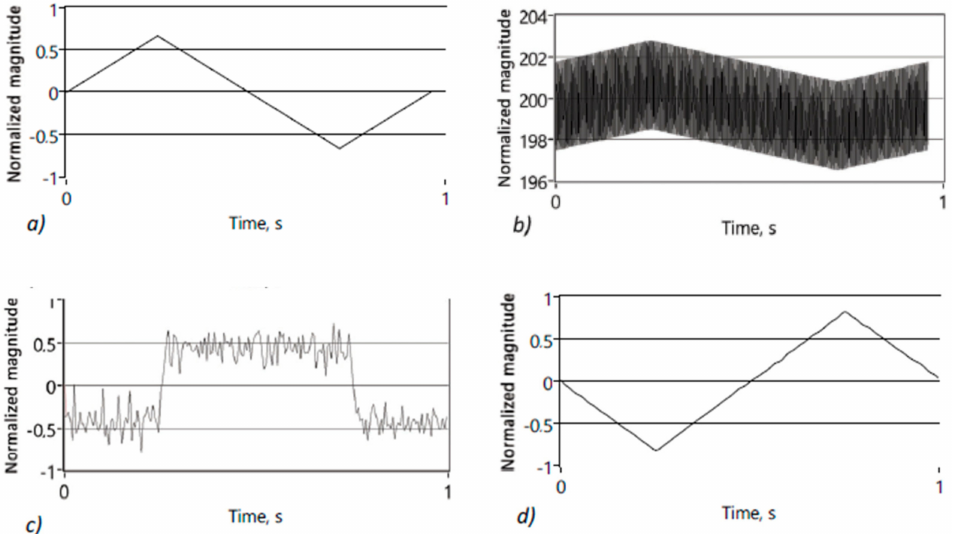
Figure 13. Modulating signal ( a ), signal after lock-in detector ( b ), synchronously integrated signal ( c ), signal after final integration ( d ). All signals are normalized for the sake of clarity. Please note that ( d ) is mirrored image of original ( a ), as predicted